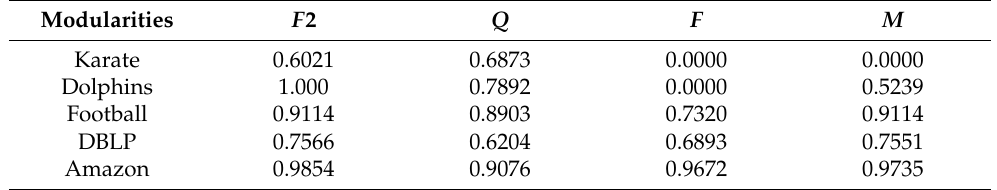
Table 2. The NMI values for the constrained Louvain algorithm with different objective functions on the ground truth networks. The NMI = 0 means the whole network constitutes a big community. Modularities F 2 Q F M Karate 0.6021 0.6873 0.0000 0.0000 Dolphins 1.000 0.7892 0.0000 0.5239 Football 0.9114 0.8903 0.7320 0.9114 DBLP 0.7566 0.6204 0.6893 0.7551 Amazon 0.9854 0.9076 0.9672